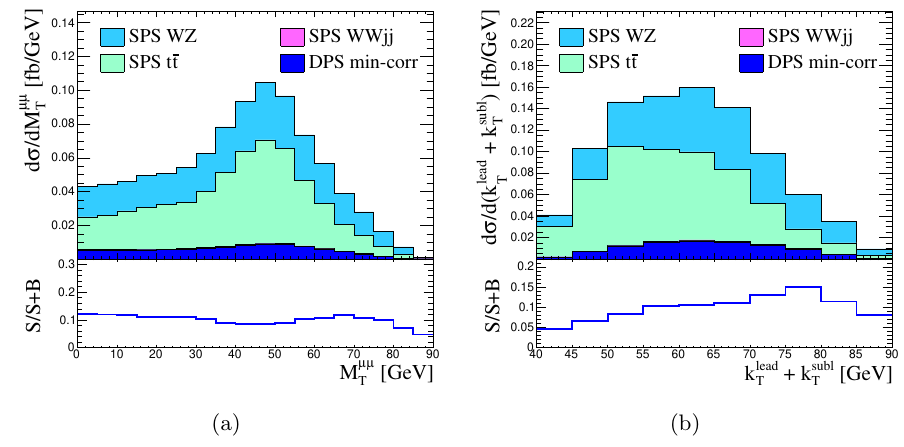
Figure 10 . An example of di-muon characteristics for signal-background discrimination: (a) the distribution of transverse mass of the muon pair and (b) the distribution of scalar sum of transverse momenta of the two